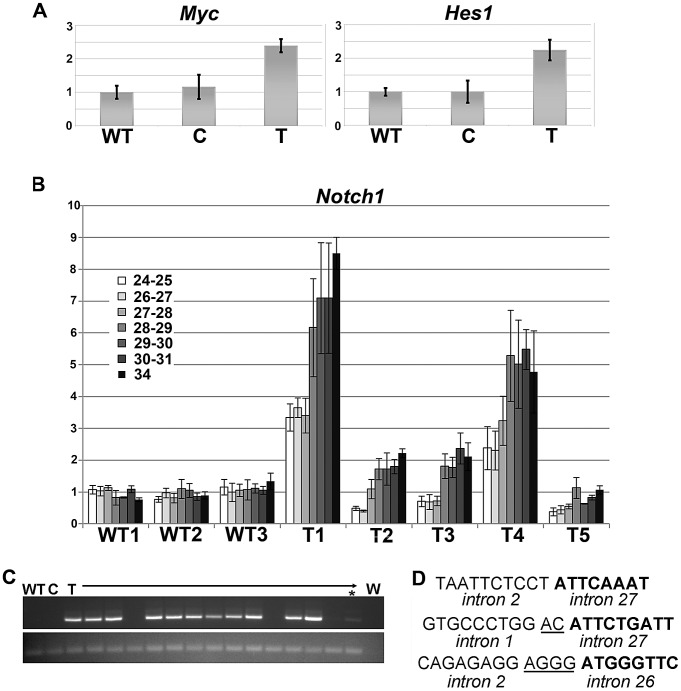

Notch1 activation due to intragenic deletions occurs during leukemogenesis in Sdl mice.WT = wild-type, C = carrier Sdl thymus, T = tumor. Error bars represent standard deviation. For all qRT-PCR data, expression in wild-type thymus was normalized to 1. A) qRT-PCR detects higher levels of expression of the Notch1 targets Myc and Hes1 in Sdl thymic tumors compared to wild-type thymus or carrier thymus. N = 3 per group. p<0.001 for comparisons of wild-type thymus or carrier thymus to tumors. B) qRT-PCR results for querying expression levels of individual Notch1 exon/exon boundaries indicated as well as exon 34 for three wild-type thymuses and five Sdl tumors. All q-PCRs were performed in triplicate. C) RT-PCR using a forward primer in exon 1 and a reverse primer in exon 30 detects abnormal Notch1 transcripts in 11 of 15 tumors (T) from Sdl mice but not in wild-type thymus (WT) or thymus from Sdl carrier mice (C) (top panel). An additional tumor (asterisk) was weakly positive. A no-RNA control (water, W) is also shown. RT-PCR for Gapdh was used to verify the presence of cDNA (bottom panel). D) Sequences surrounding three genomic breakpoints in Notch1 cloned from Sdl tumors. 5′ introns are in regular font, 3′ introns are in bold font. Microhomology is underlined.